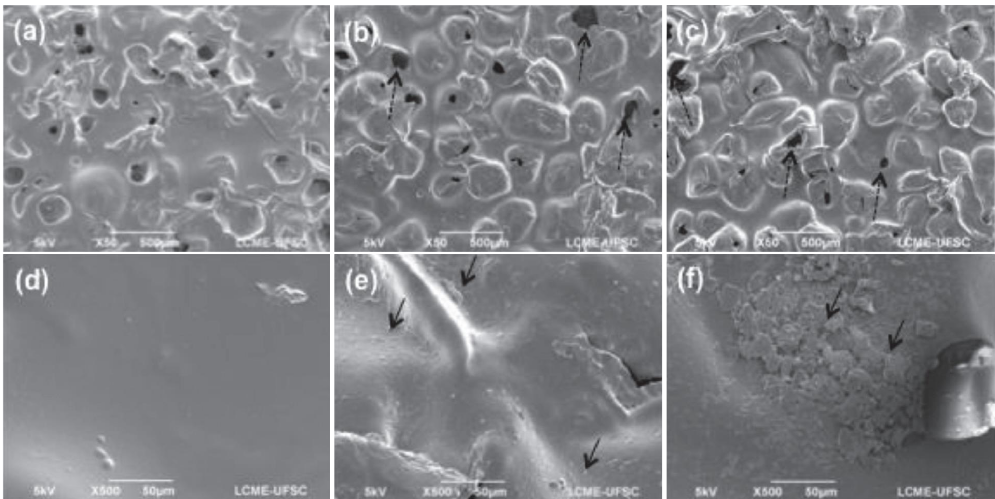
Figure 2: SEM images of rough membranes at 200X: (a) as-received, (b) after acidic degradation, and (c) after basic degradation; and at 500X: (d) as-received, (e) after acidic degradation, and (f) after basic